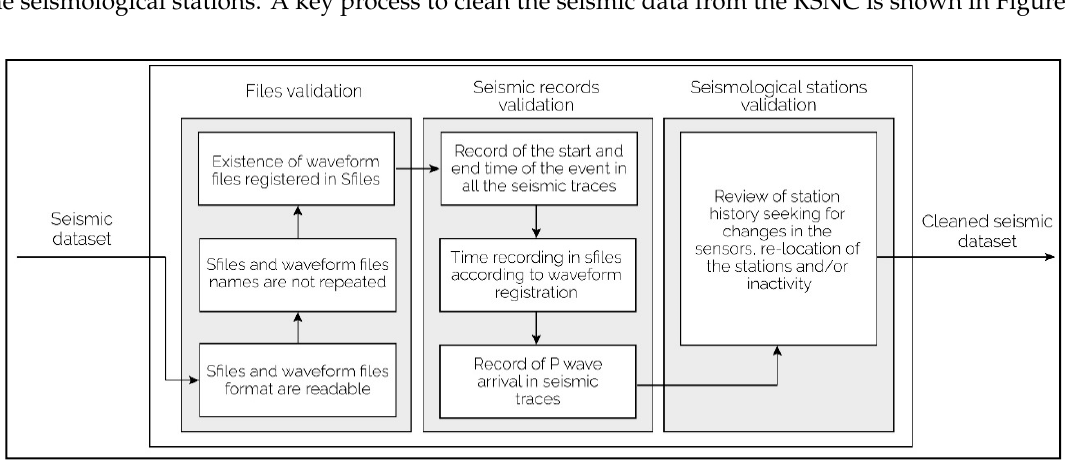
Figure 3. Seismic data cleaning process for RSNC files.